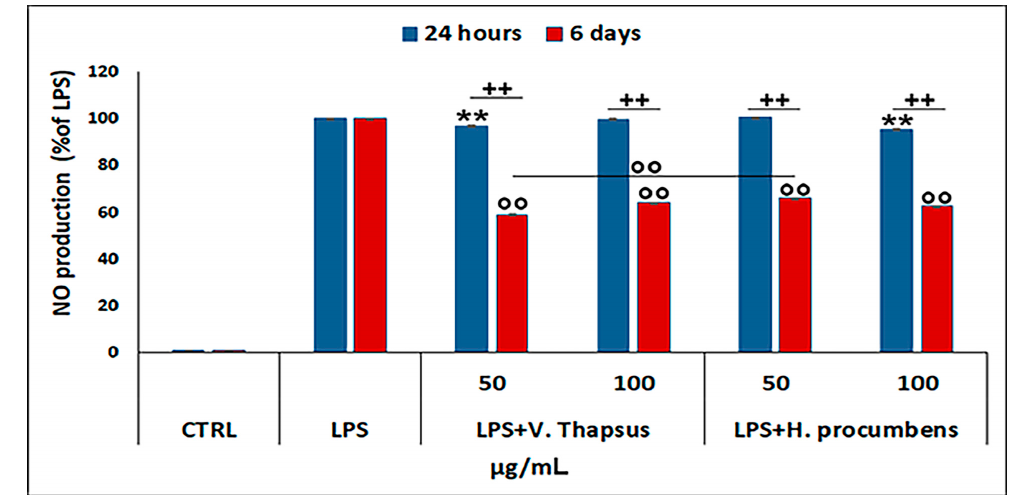
Figure 3. Effect of V. thapsus on nitric oxide production in RAW 264.7 cells. Griess assay performed on the supernatant of LPS-stimulated RAW 264.7 treated with V. thapsus and H. procumbens extracts (50 and 100 µ g/mL) for 24 h and 6 days. H. procumbens = positive control. Data are represented as the means ± SD of three independent experiments. ANOVA test p -values were reported ( p < 0.0001), and (**, ++, ◦◦ p < 0.01) indicate significant differences between the two groups, as reported by the Holm post hoc